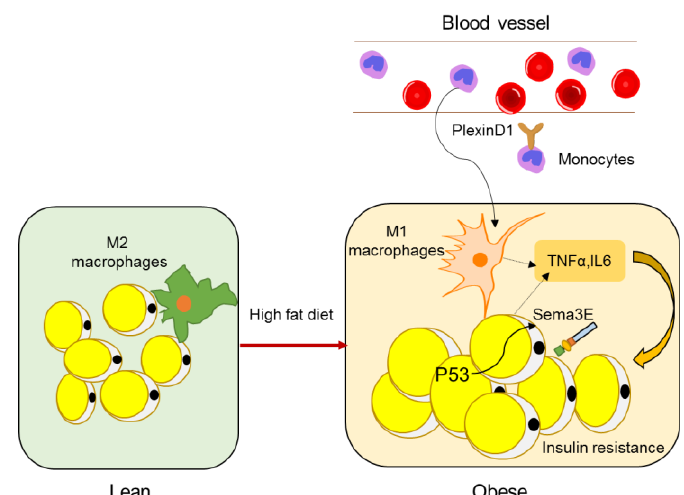
Figure 4. Semaphorins in adipose inflammation. In lean adipose tissue, the main macrophages are quiescent M2 macrophages, whereas, in obese adipose tissue, monocytes from peripheral blood are recruited to adipose tissue and macrophages become M1 polarized macrophages (other immune cell types such as T cells are not shown here), leading to an inflammatory state, which is a main cause of insulin resistance. Expression of Sema3E is induced by p53 in adipocytes and promotes the influx of monocyte-derived macrophages through its receptor PlexinD1.